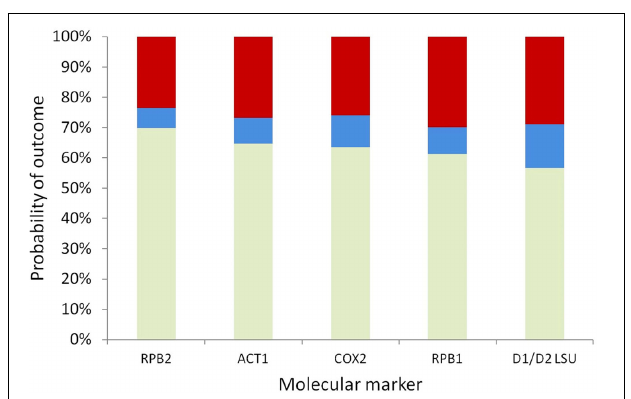
FIGURE 4 | Stacked probabilities of correct resolution (bottom, light green), polytomy (middle, blue), and incorrect resolution (top, dark red) of the backbone node of the haploid Candida clade based on the GTR model, for five markers.